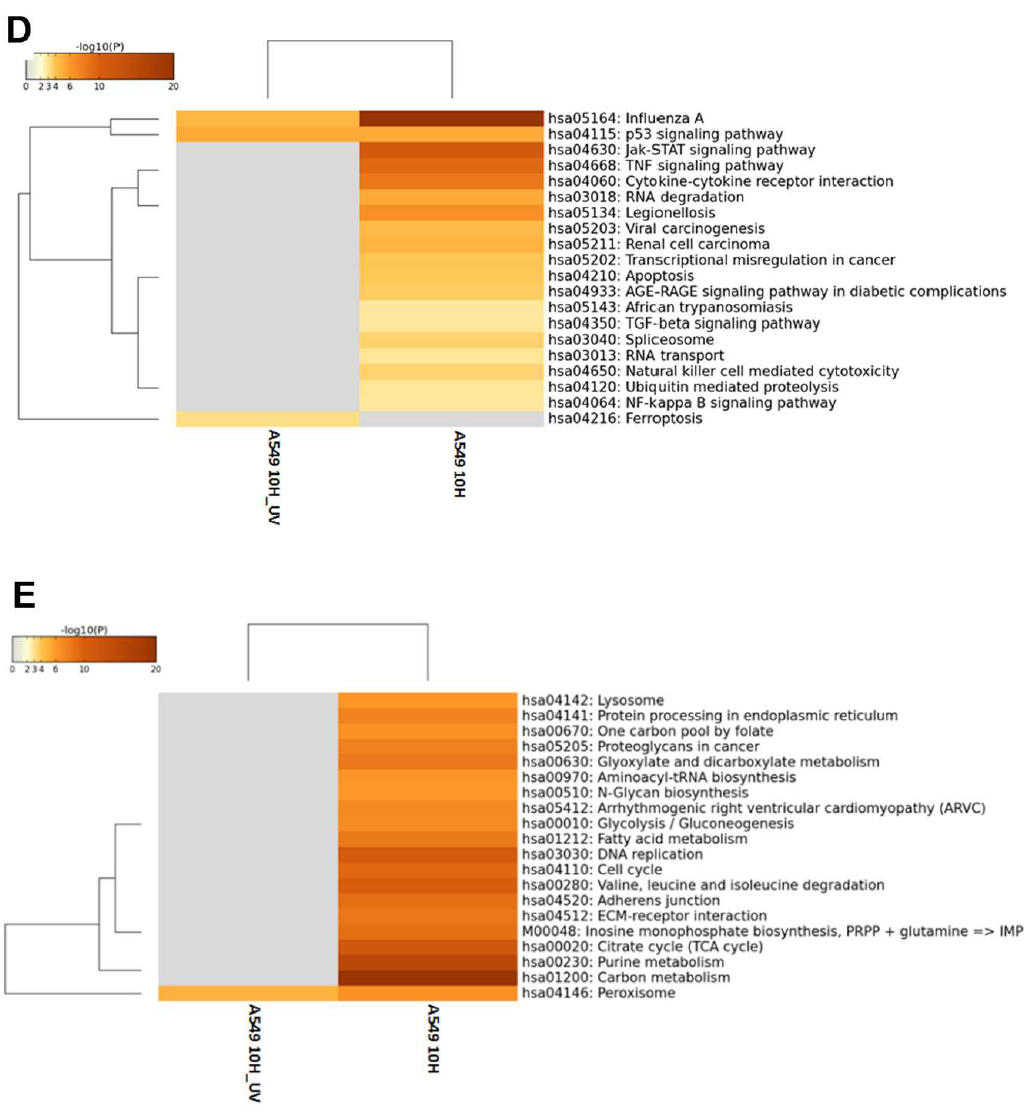
Figure 2. Differentially expressed genes (DEGs) in A549 cells infected with H7N9 virus. ( A ) Principal component analysis of the gene expression changes at 2 and 10 hours post-infection (hpi). ( B ) Number of up- and down-regulated genes in untreated and ultra-violet (UV)-treated virus infections. ( C ) Pairwise analysis of the DEGs at 10 hpi showing (i) up- and (ii) down-regulated genes in untreated and UV-treated virus infections. ( D ) Functional annotation of up-regulated DEGs. ( E ) Functional annotation of down-regulated